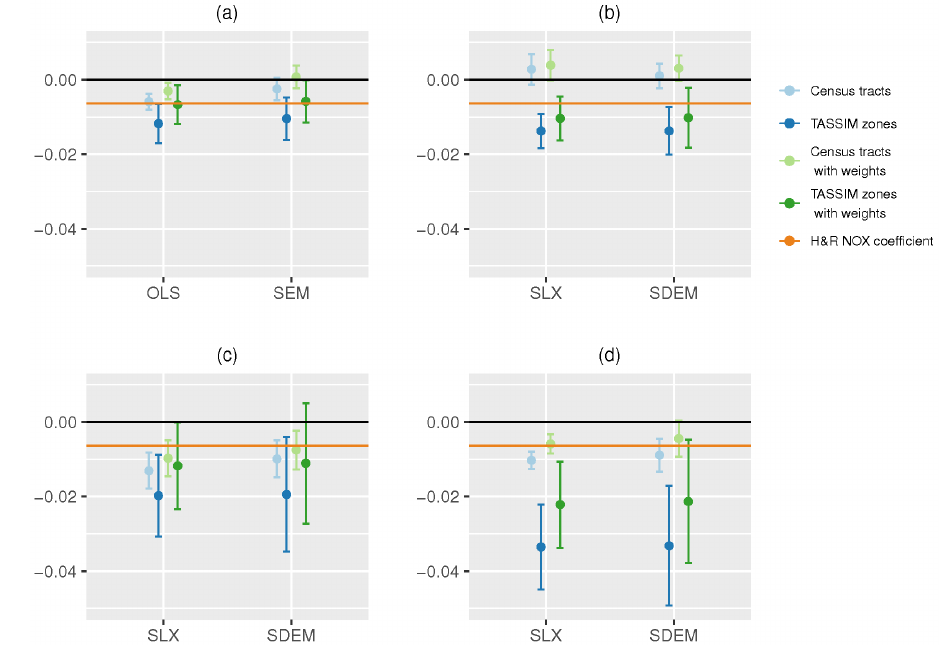
Figure 3: NOX coefficient values (a) and direct (b), indirect (c) and total (d) impacts and 95% standard error bars for OLS and SEM models, weighted and unweighted, for census tract and approximate TASSIM zone data sets; the Harrison, Rubinfeld (1978c, p. 100) coefficient value is shown in